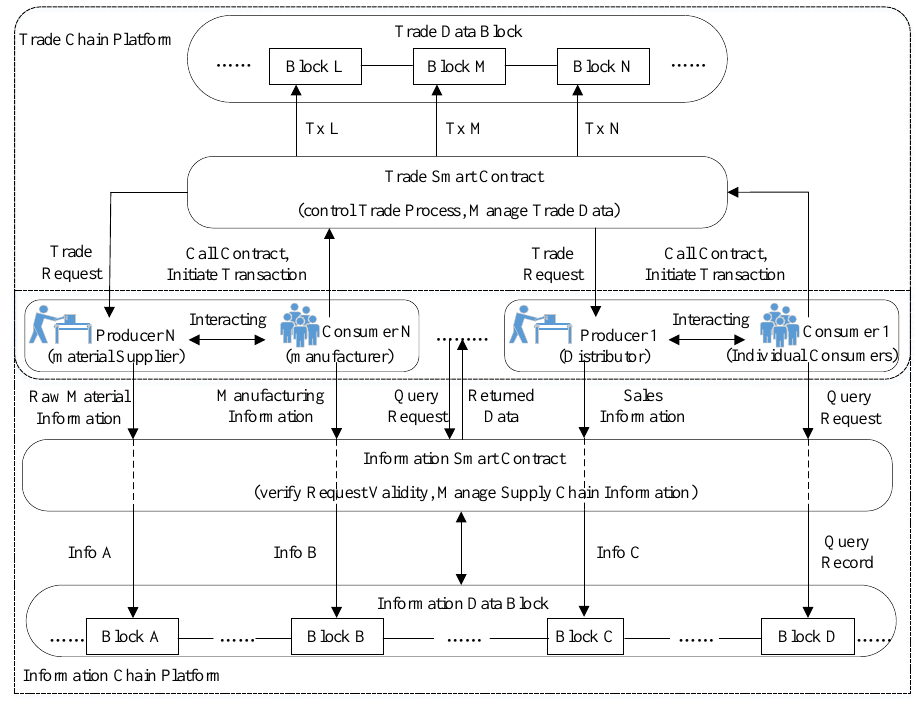
Figure 3. Overall framework of supply chain system.